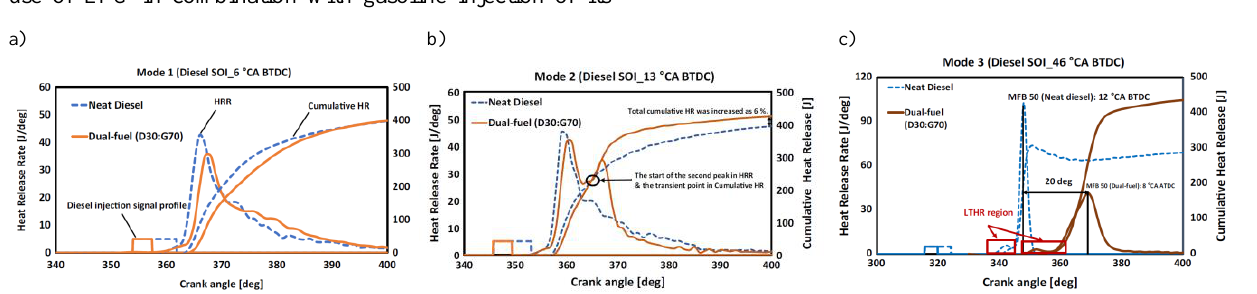
Fig. 2. Combustion process conditions for single-fuel and dual-fuel (DF and gasoline) for an engine with different fuel supply modes: a) mode 1, b) mode 2, c) mode 3 (reproduced from